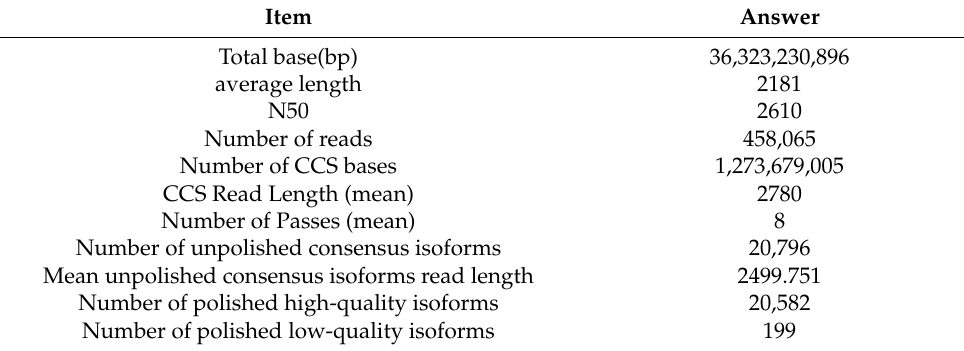
Table 1. Summary of the SMRT sequencing